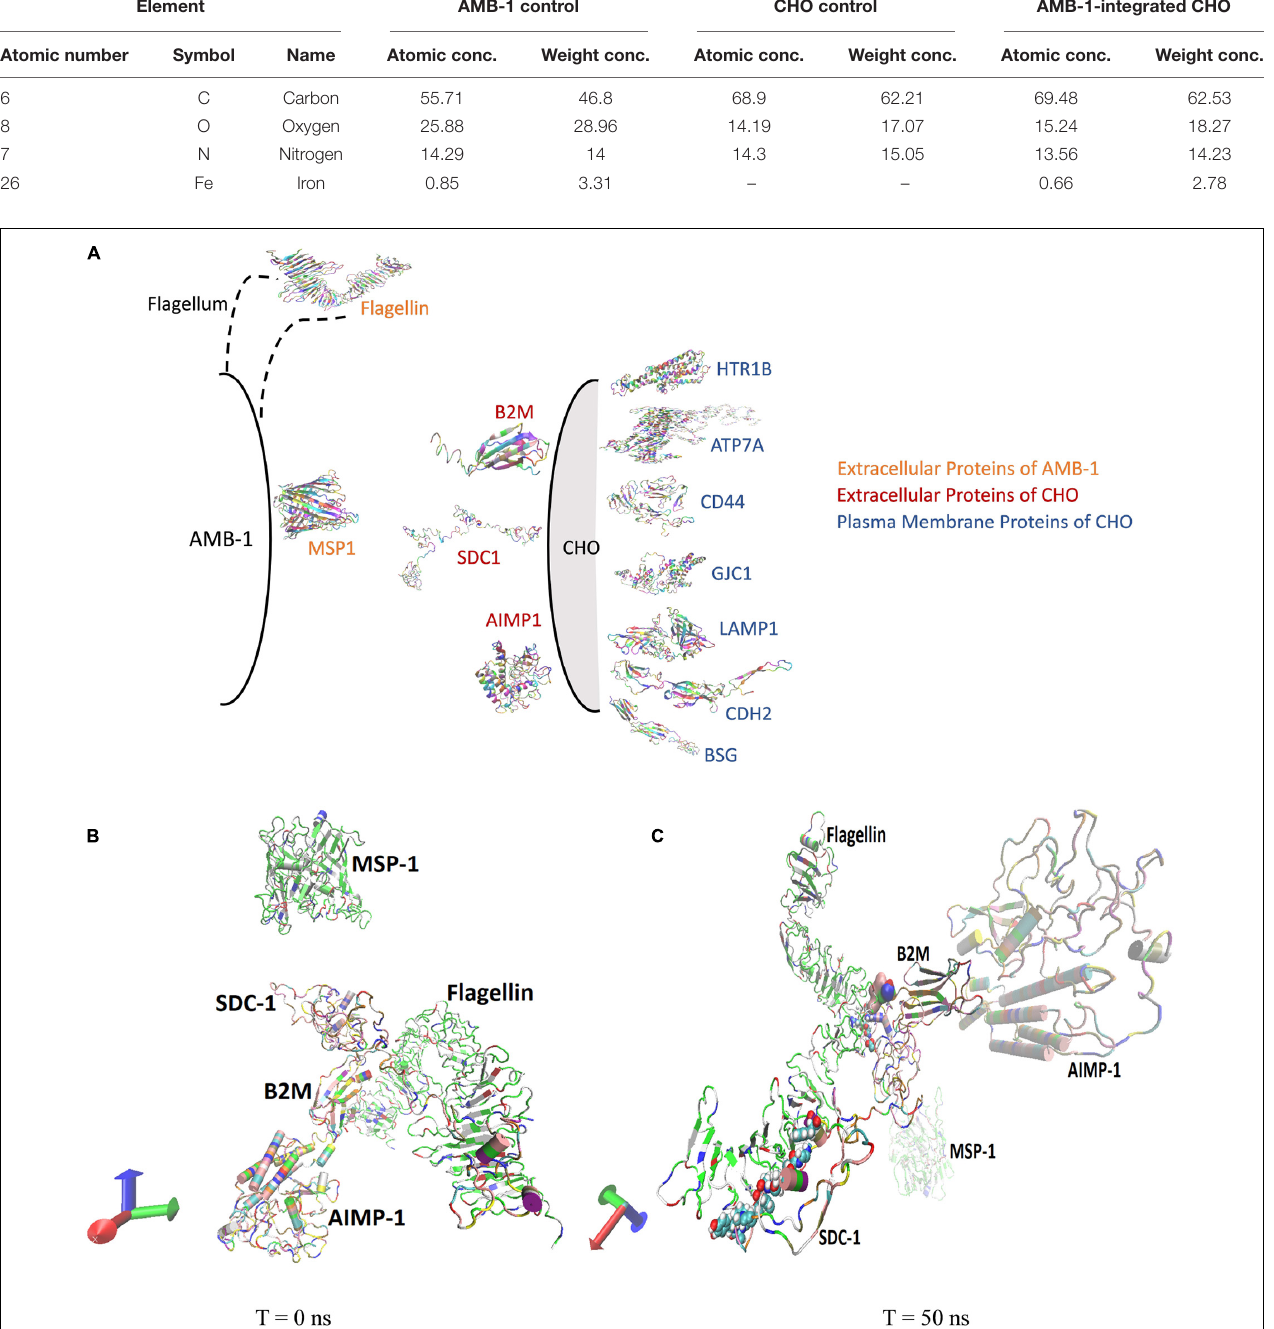
FIGURE 4 | (A) AMB-1 and CHO surface proteins used for performing molecular dynamics simulation. (B) Spatial location of proteins at time (B) T = 0 ns and (C) T = 50 ns, respectively.